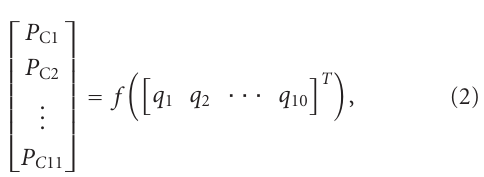
the gait cycle and, consequently, the joint trajectories and generalized forces are not a ff ected